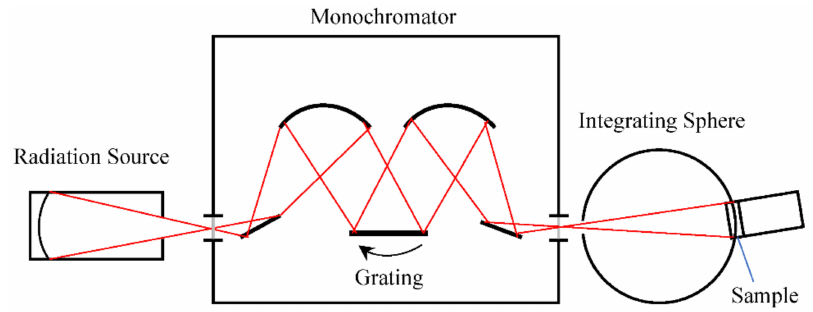
Figure 10. Schematic diagram of the optical system